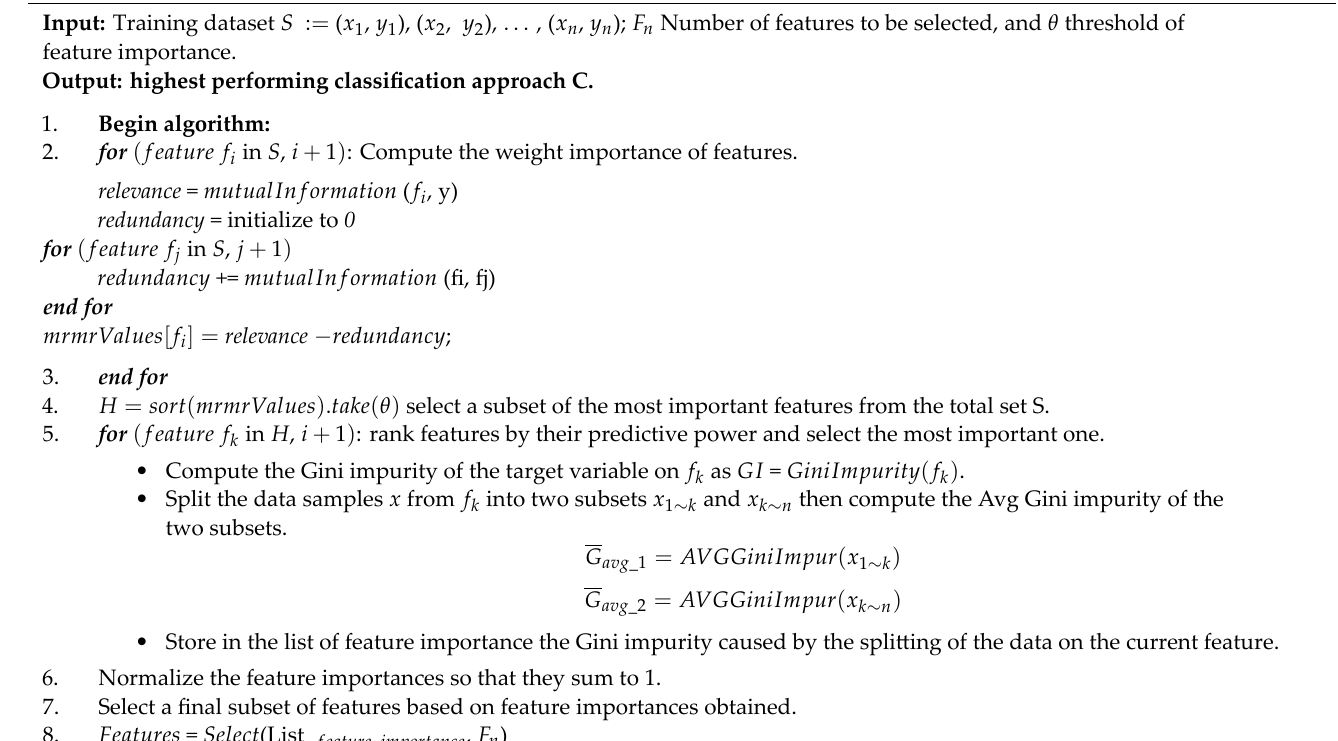
Algorithm 1: Proposed model for Dental Caries